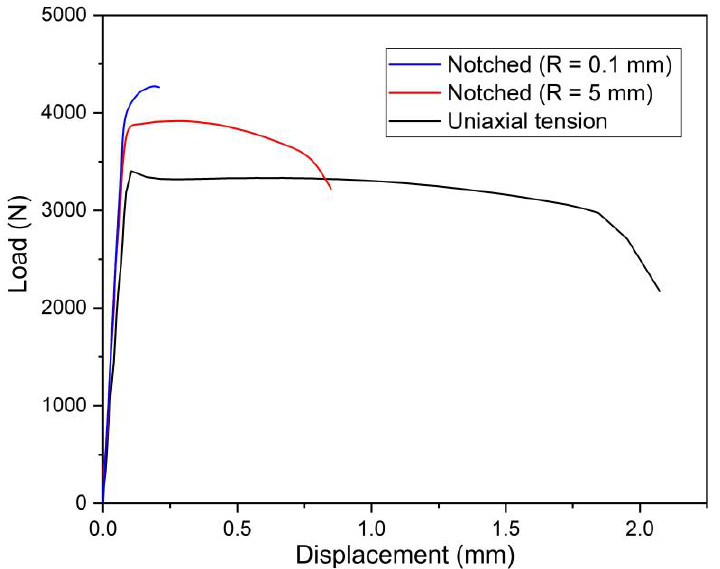
Figure 5. Load—displacement curves for the uniaxial tensile sample and the notched samples with a notch radius of 5 mm and 0.1 mm respectively.